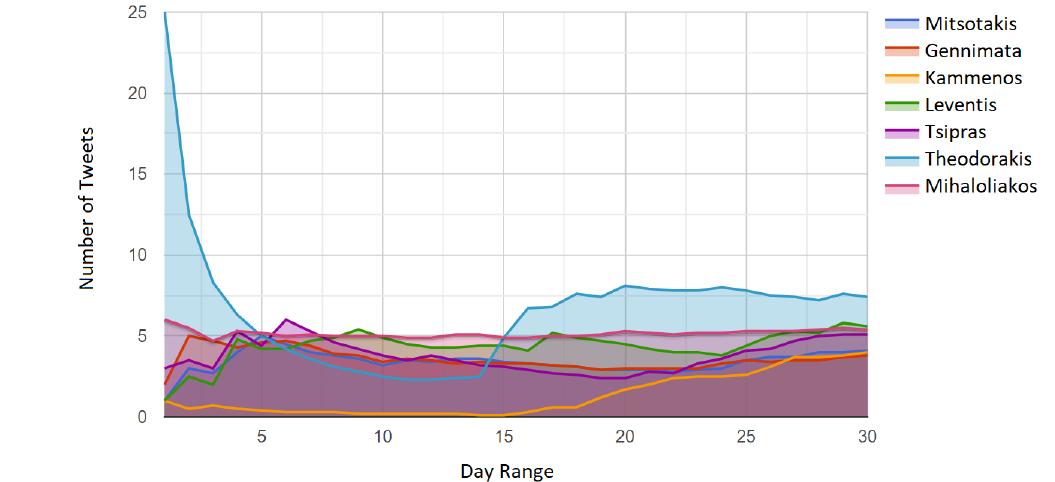
Figure 4. Number of tweets for each day of the month.